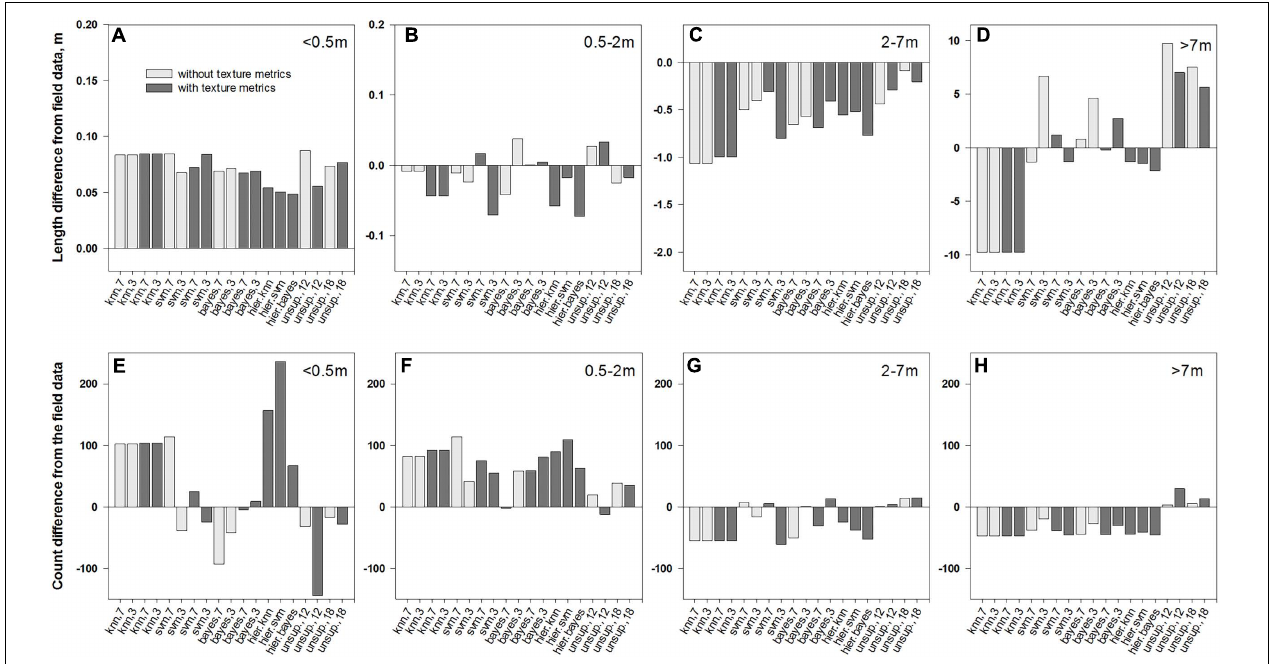
FIGURE 7 | Differences in average length of patch segments (A–D) and their counts (E–H) between field data and the intersections of medusahead classification outcomes with full transect lines summarized for different patch sizes: (A,E) < 0.5 m; (B,F) 0.5–2 m; (C,G) 2–7 m; and (D,H) > 7